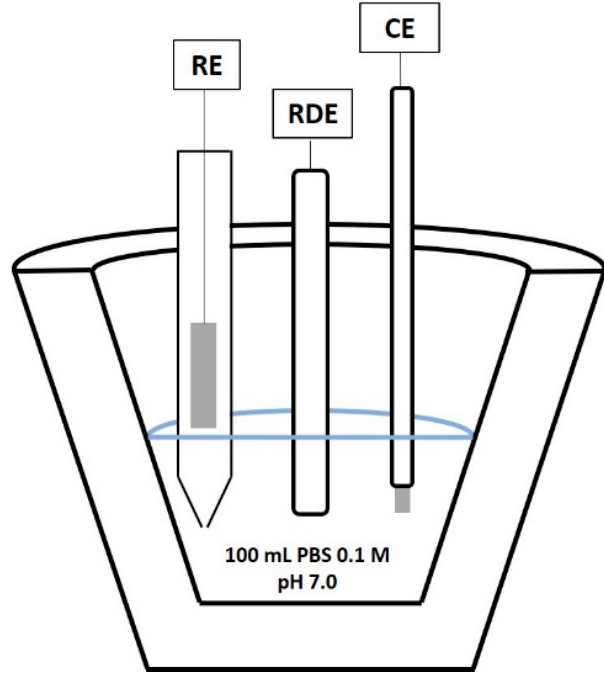
Figure 2. Schematic representation of the experimental setup.